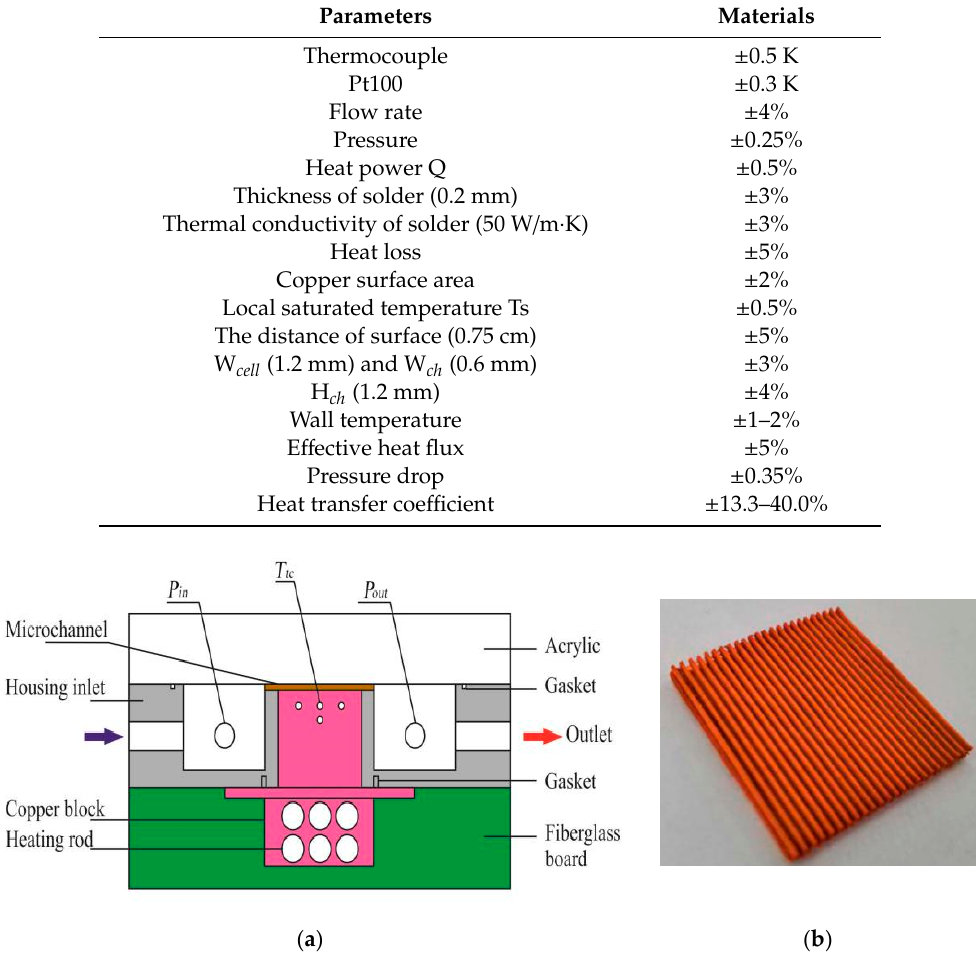
Figure 1. Schematic diagram of experimental system. 1. Thermostatic water bath. 2. Regulation valve. Table 1. Uncertainties in variables.